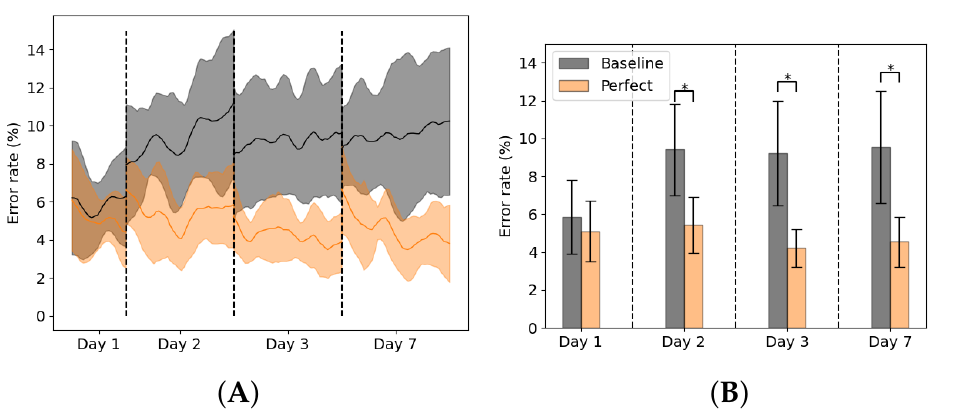
Figure 4. Average forward prediction error rates over all subjects per day for the baseline error rate (gray) and retraining using perfect labels (orange). ( A ) The average error rate over the measurement day. ( B ) The average error rate per day. Asterisk indicates significant